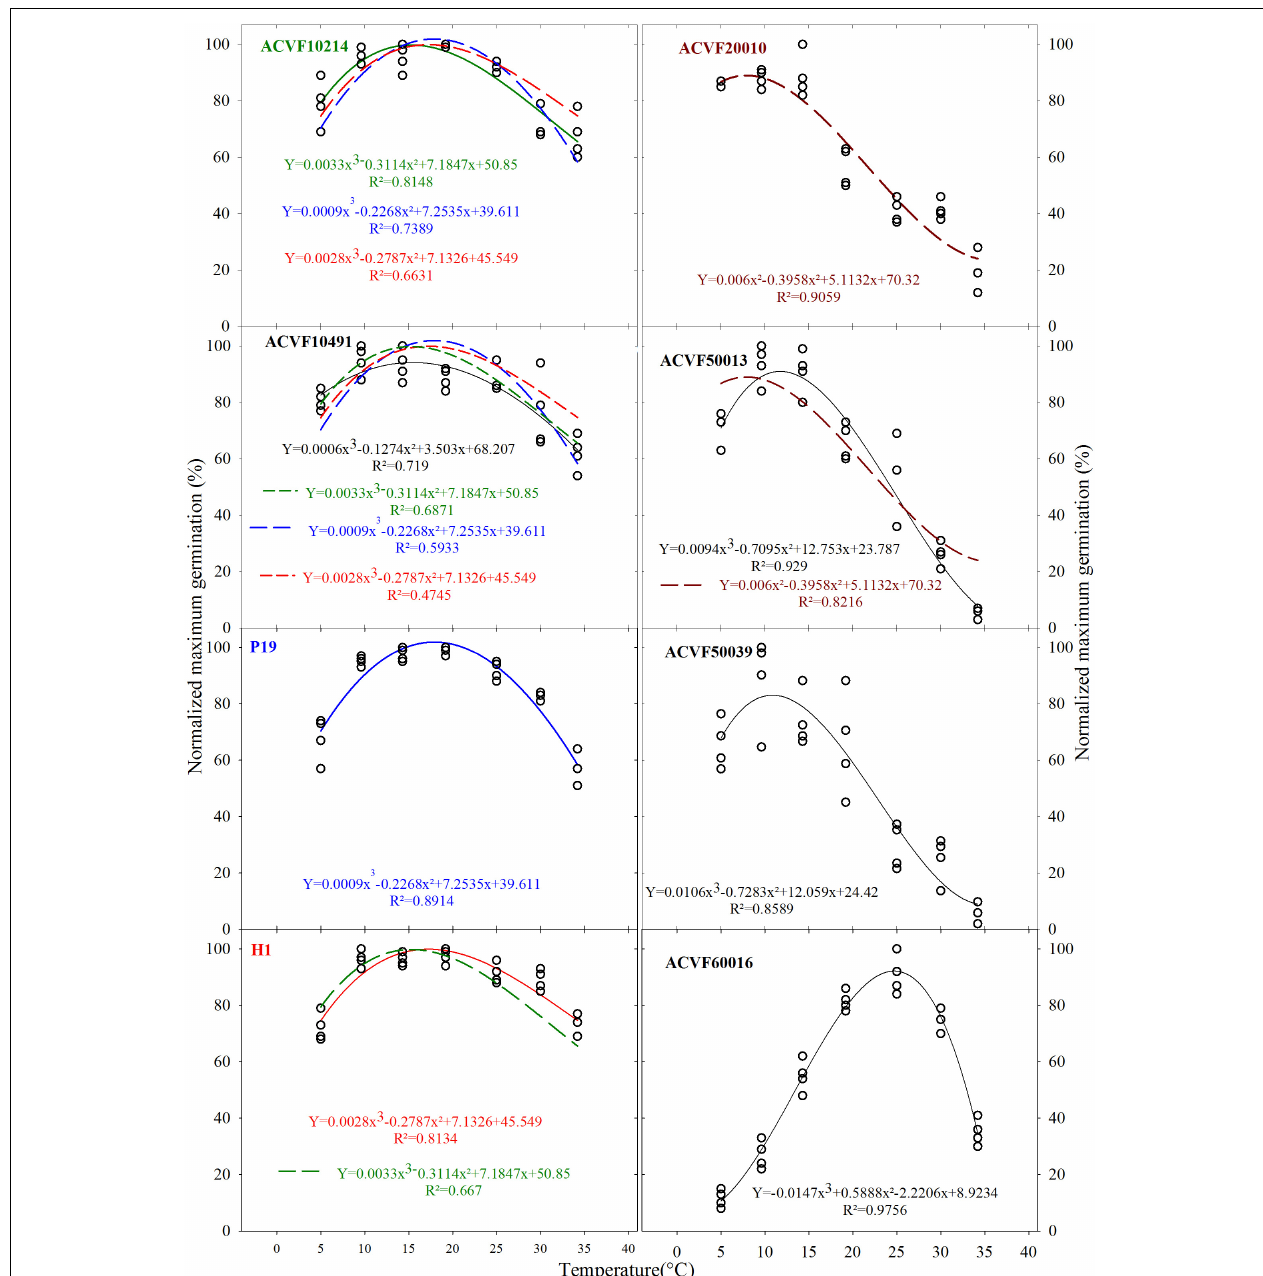
FIGURE 2 | Normalized germination percentage in response to a constant temperature of eight accessions of Lolium perenne